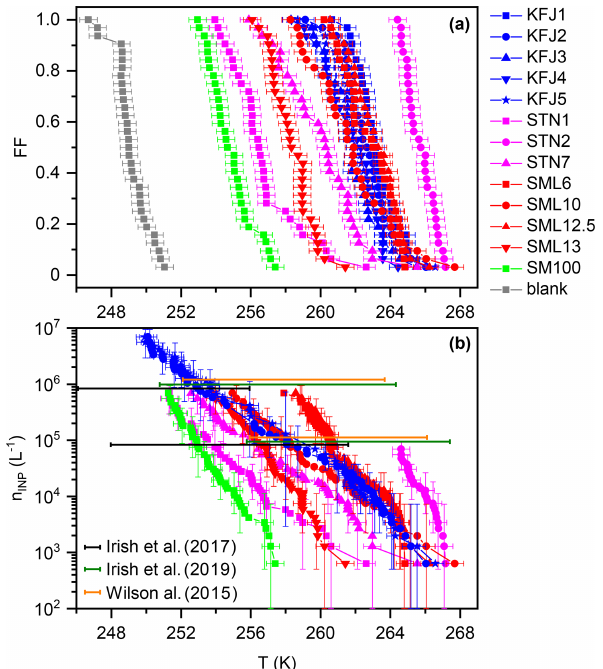
Figure 2. (a) Frozen fraction, FF, curves of the investigated sam- ples from cold-stage measurements with INSEKT, corrected for the freezing point depression by the salts. (b) Cumulative INP concen- trations, n INP (L − 1 ), as computed with Eq. (1) from the measure- ments in panel (a) and additional INSEKT measurements where the solutions were diluted by factors of 10 and 100 with ultrapure water to extend their n INP (L − 1 ) spectrum to lower temperatures. The er- ror bars reflect the statistical uncertainty (Koop et al., 1997). The coloured horizontal bars, positioned at n INP = 10 5 and 10 6 L − 1 (shown with a slight vertical offset as a matter of clarity), comprise the range of temperatures where such INP concentrations were en- countered in previous droplet freezing experiments with Arctic mi- crolayer samples (Wilson et al., 2015; Irish et al., 2017,